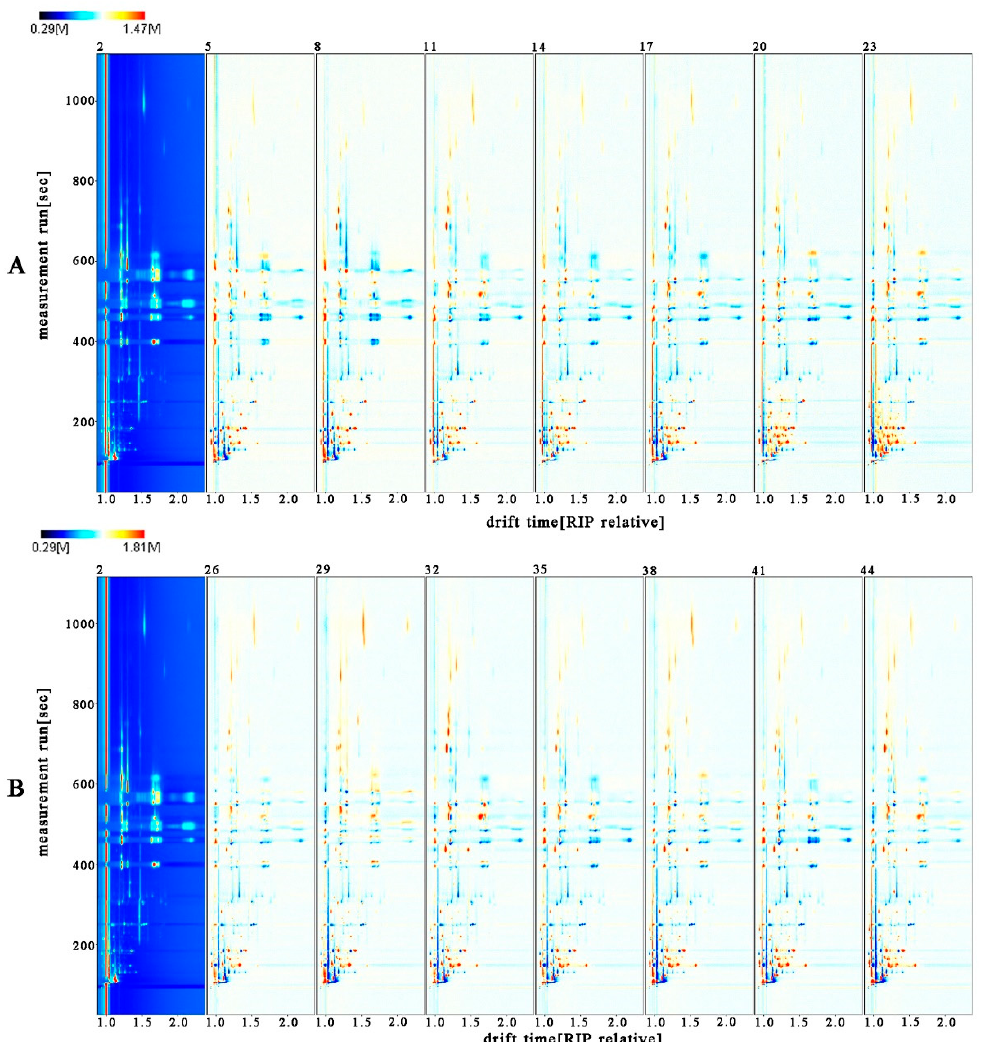
Figure 2. 2D topographic images of fresh kumquats (FKs) and vacuum osmosis with sugar and then hot air drying kumquats (VS-ADKs). 2: FKs; 5: kumquats with vacuum sugaring and then hot air drying for 0 h (VS-ADKs for 0 h); 8: VS-ADKs for 1 h; 11: VS-ADKs for 2 h; 14: VS-ADKs for 4 h; 17: VS-ADKs for 6 h; 20: VS-ADKs for 8 h; 23: VS-ADKs for 10 h; These are showed in figure 2A. 2D topographic images of fresh kumquats (FKs) and atmospheric pressure osmosis with sugar and then hot air drying kumquats (AS-ADKs). 2: FKs; 26: kumquats with atmospheric pressure sugaring and then hot air drying for 0 h (AS-ADKs for 0 h); 29: AS-ADKs for 1 h; 32: AS-ADKs for 2 h; 35: AS-ADKs for 4 h; 38: AS-ADKs for 6 h; 41: AS-ADKs for 8 h; and 44: AS-ADKs for 10 h; These are showed in figure 2B.